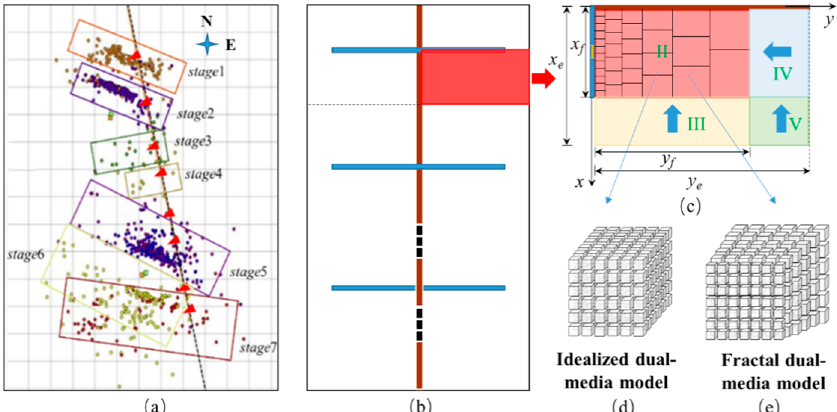
Figure 2. Development of physical and mathematical models. ( a ) Map of micro-seismic monitoring results; ( b ) simplified physical model presented in this study; ( c ) multi-linear mathematical model presented in this study (modified from Sheng et al. [20]); ( d ) idealized homogeneous dual-media model (IDMM) for stimulated reservoir volume (SRV) (modified from Warren and Root [29]); and ( e ) fractal heterogeneous dual-media model (FDMM) for SRV.